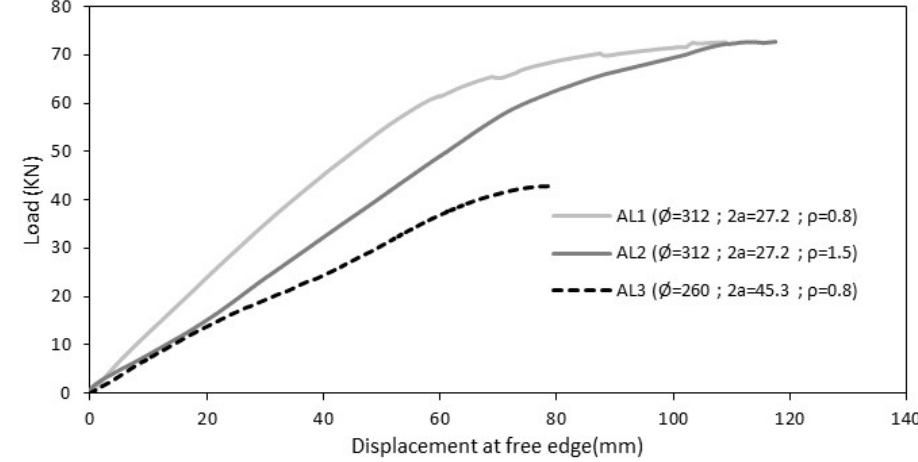
Table 4. Experimental results obtained in SENB specimens. K Nmat in cracked specimens correspond to